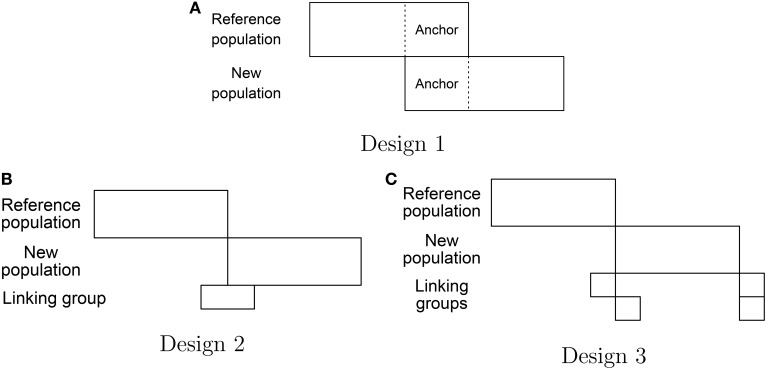
Three non-equivalent group equating designs. (A) Design 1, (B) Design 2, (C) Design 3.